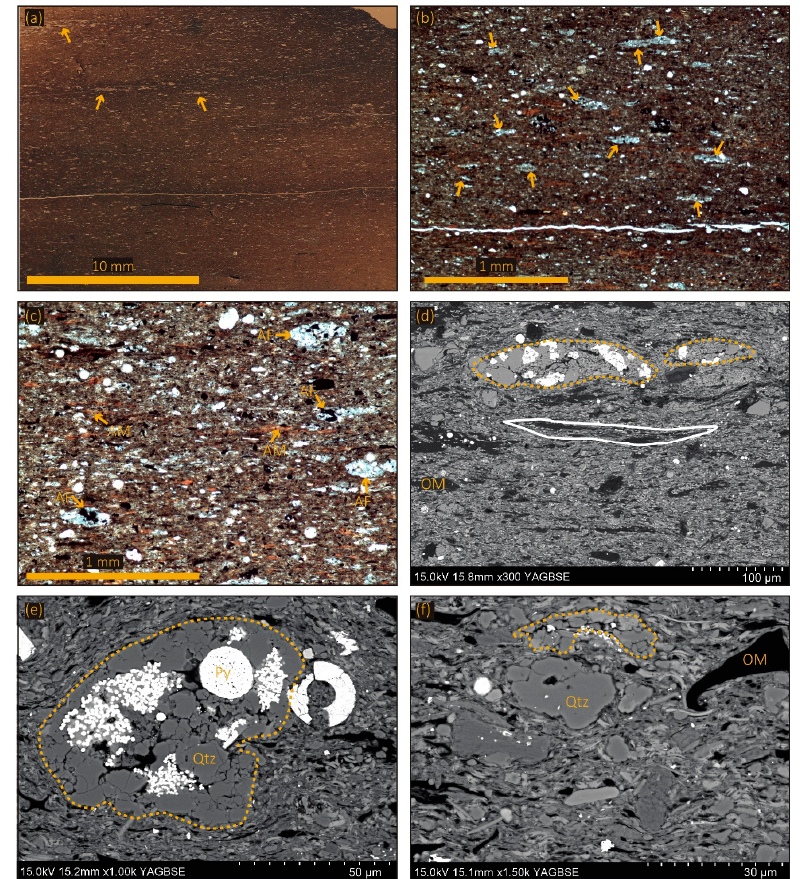
Figure 6. Facies 4: Agglutinated foraminifera bearing, medium to coarse, carbonaceous mudstone. Sample EB 46.60 m. ( a ) Low power optical micrograph of a thin section. Yellow arrows point to collapsed agglutinated foraminifera. ( b ) Optical micrograph. Yellow arrows indicate abundant agglutinated foraminifera. ( c ) Optical micrograph showing agglutinated foraminifera (AF) amongst algal macerals (AM). ( d ) Backscattered electron photomicrographs showing amorphous organic material (AOM), agglutinated foraminifera (yellow dashed line), and organo-mineralic aggregate (white dotted line) in an argillaceous matrix. ( e ) Backscattered electron photomicrographs showing an agglutinated foraminifera (dashed yellow lines) comprising quartz, pyrite, and surrounding matrix, reprinted with permission from Atar et al. (2019a) [14]. ( f ) Backscattered electron photomicrographs quartz (e.g., Qtz), clay grains, organic material (OM), agglutinated foraminifera (yellow dashed line) in an argillaceous matrix.